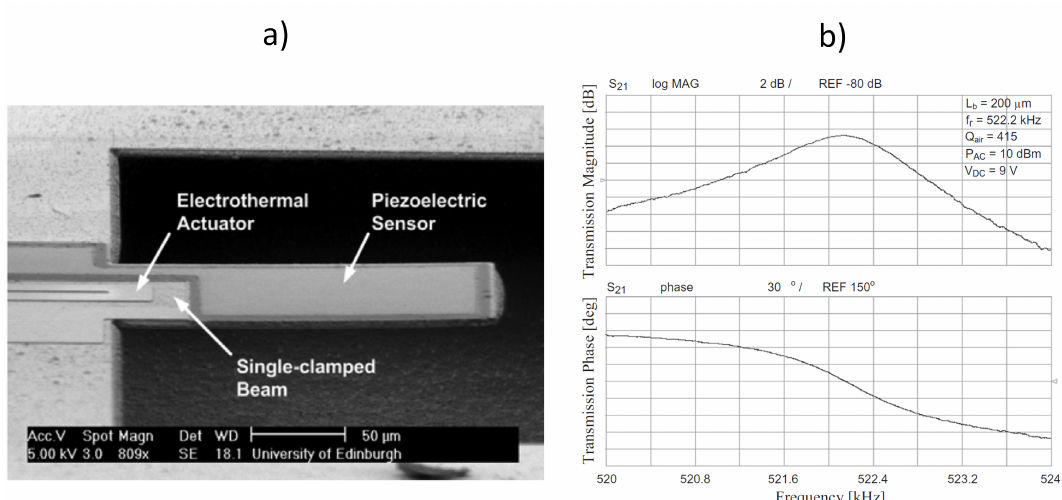
Figure 15. Electrothermally-actuated and piezoelectrically-sensed 3C-SiC cantilever resonator, ( a ) SEM image ( b ) piezoelectrically-measured frequency response, both magnitude and phase (electrothermal actuation with input AC signal power of 10 dBm and DC bias voltage of 9 V) [60]. Reprinted from Microelectron. Eng., 145, Sviliˇci´c et al., Tunable MEMS cantilever resonators electrothermally actuated and piezoelectrically sensed, 38–42, c (cid:13) 2015, with permission from Elsevier.